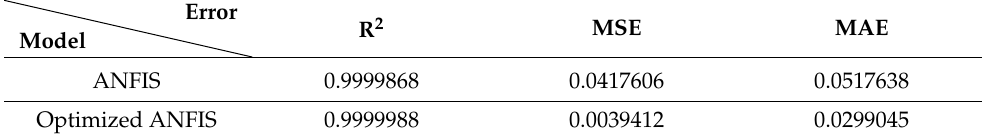
Table 7. The comparison between the ANFIS model and the Optimized ANFIS